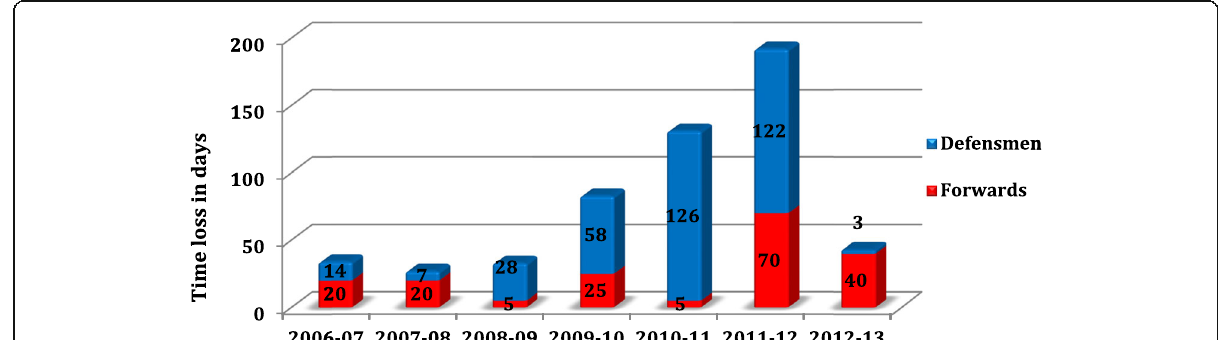
Fig. 10 Time loss in days depending to concussion by